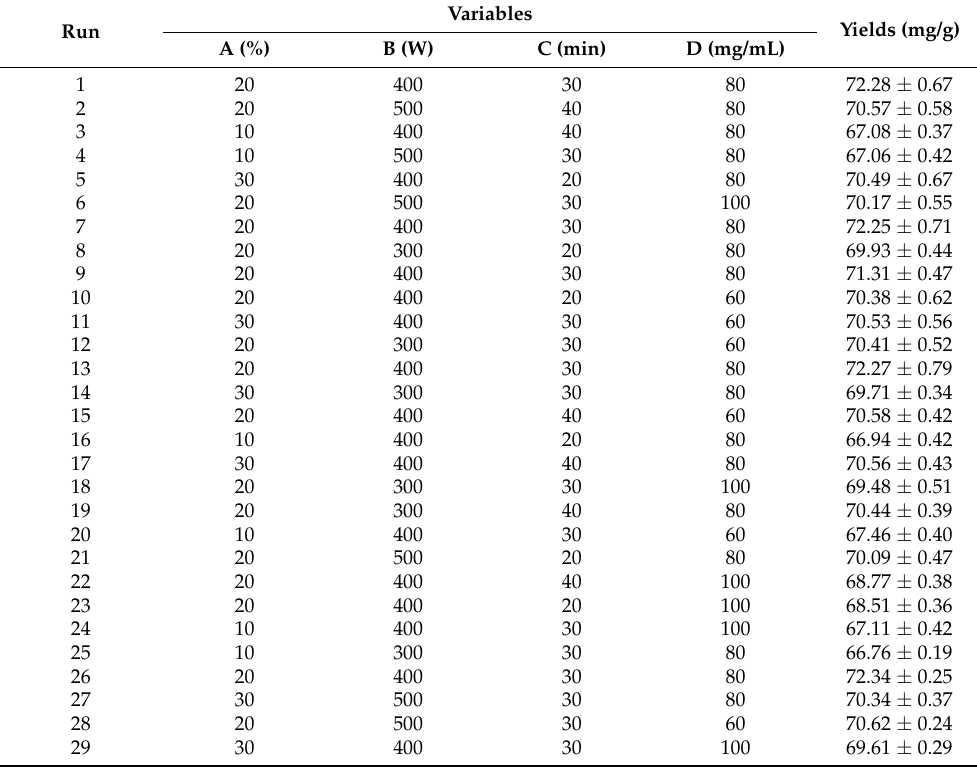
Table 2. The results of Box–Behnken design for NADES-MAE optimization.